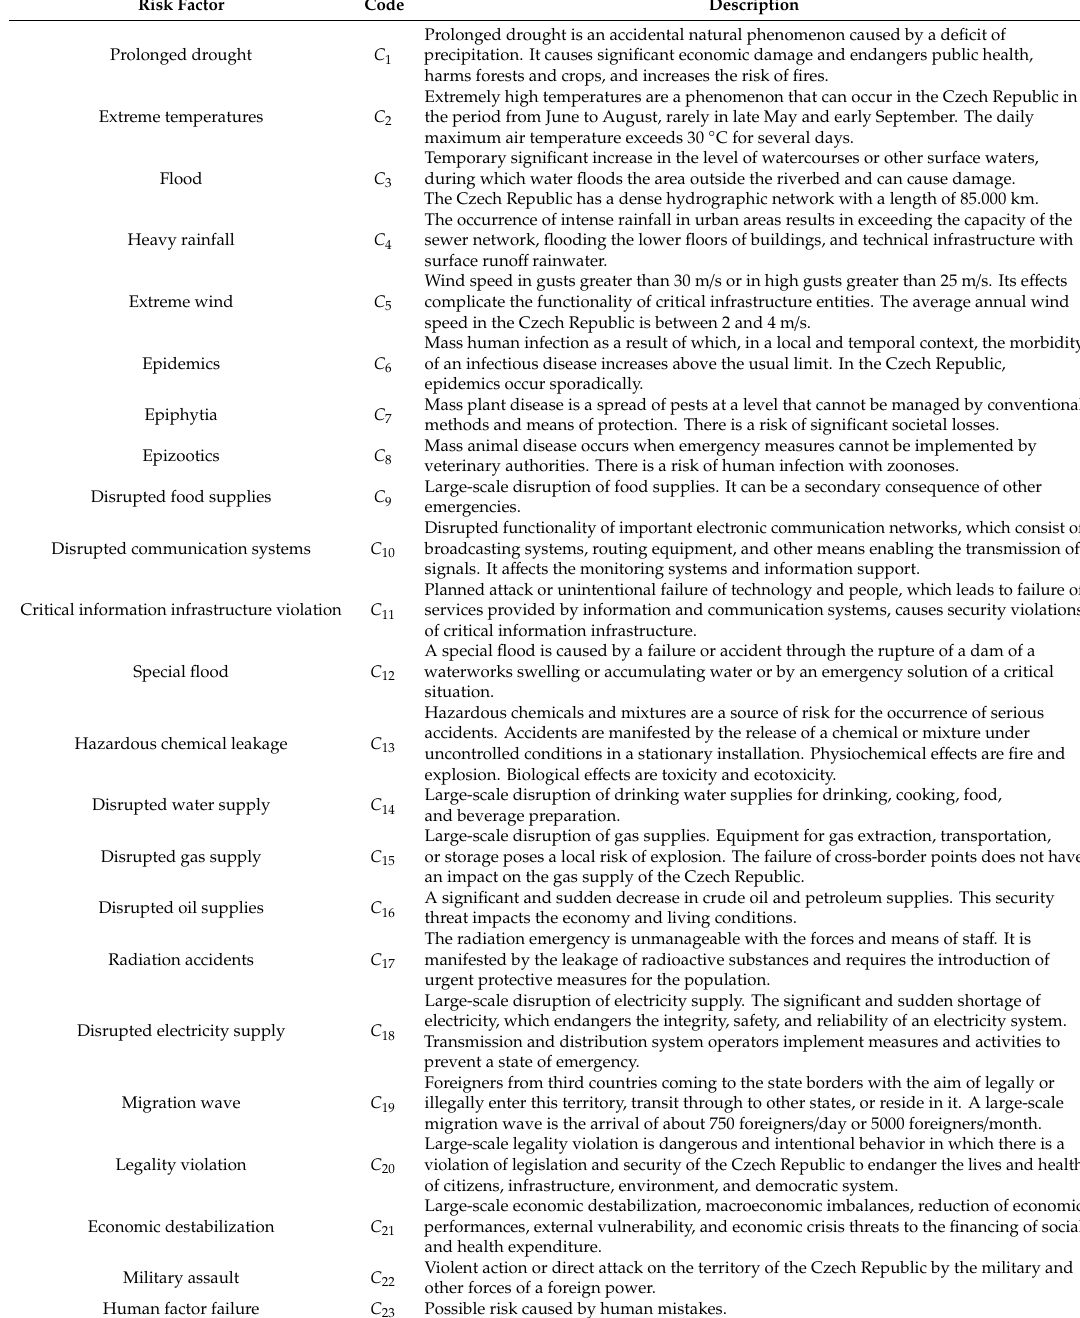
Table 3. Risk factors influencing railway infrastructure in the Czech